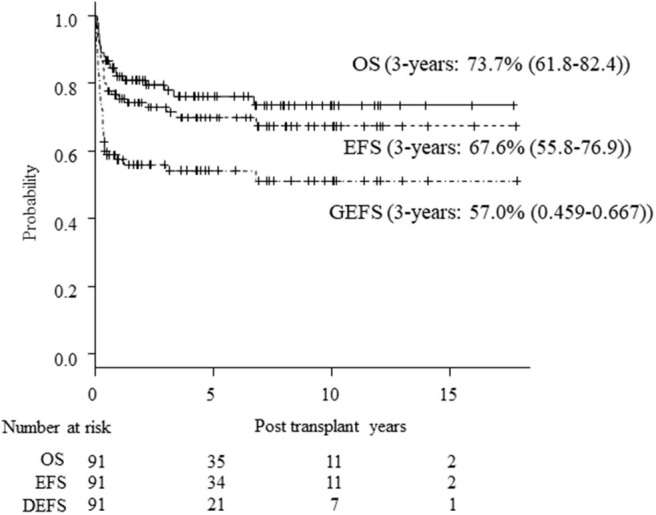
Kaplan-Meier estimates of OS/EFS/GEFS in all patients. Kaplan-Meier estimates of overall survival (OS), event-free survival (EFS), and GVHD-free, event-free survival (GEFS) of CGD patients undergoing HCT.